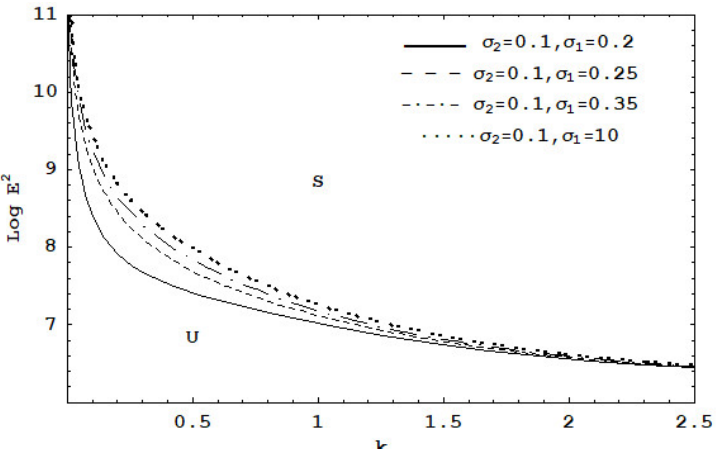
with wavenumber k for different values of the 0